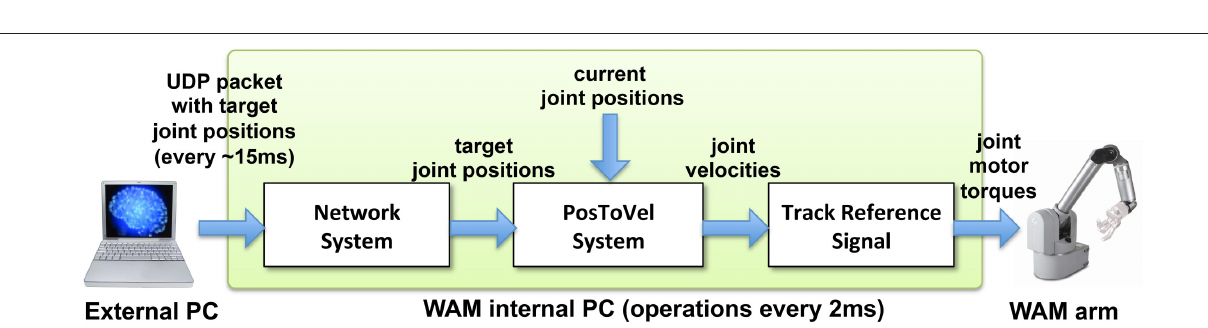
FIGURE 4 | Diagram of WAM robot arm control method. The external processor sends UDP packets with the target joint positions approximately every 15ms. The Libbarrett code running synchronously at 500Hz in the internal WAM CPU, extracts the target joint angular position vectors (Network System); converts them into joint angular velocities (PosToVel System); and generates the required joint torques for each motor using the TrackReferenceSignal